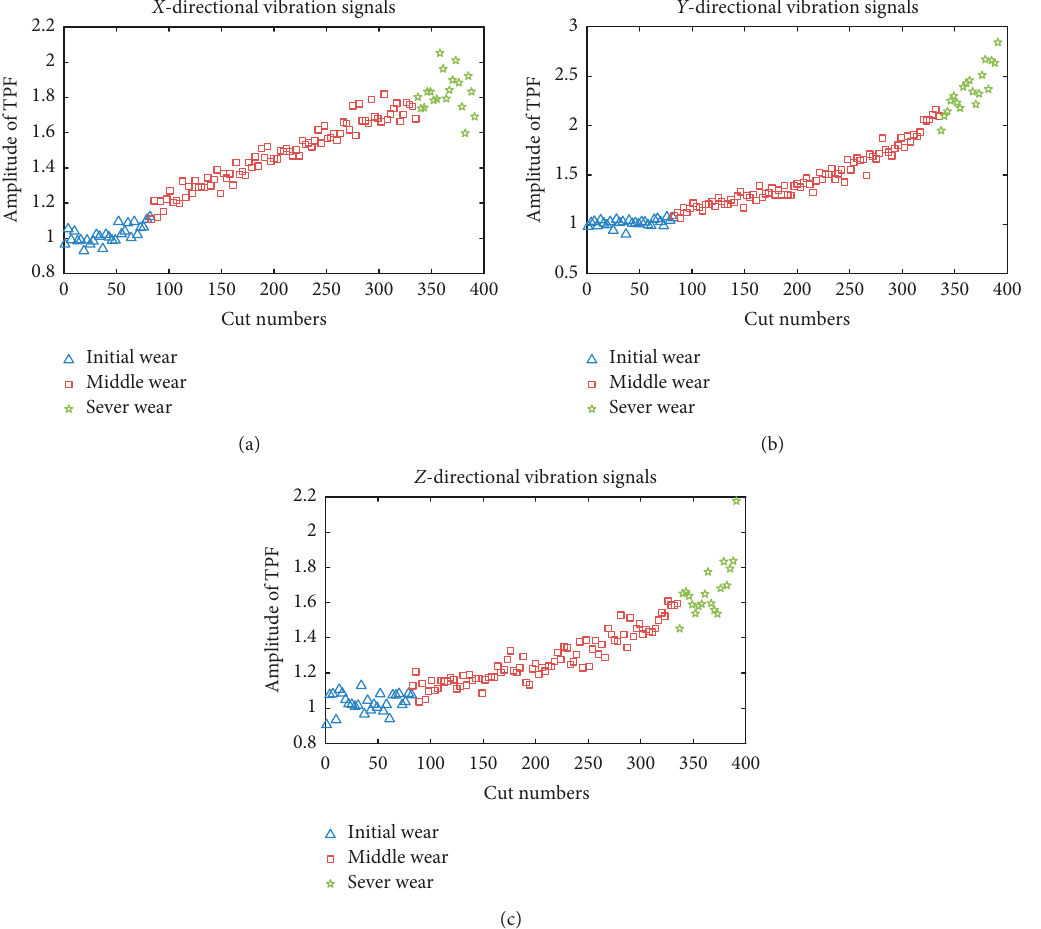
Figure 9: Vibration signal feature extraction in frequency domain: (a) X -directional vibration signals, (b) Y -directional vibration signals, and (c) Z -directional vibration